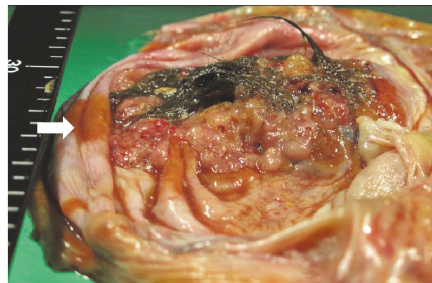
Figure 3: Resected specimen. Protruding lesions are observed on a portion of the wall of the right ovarian tumor.